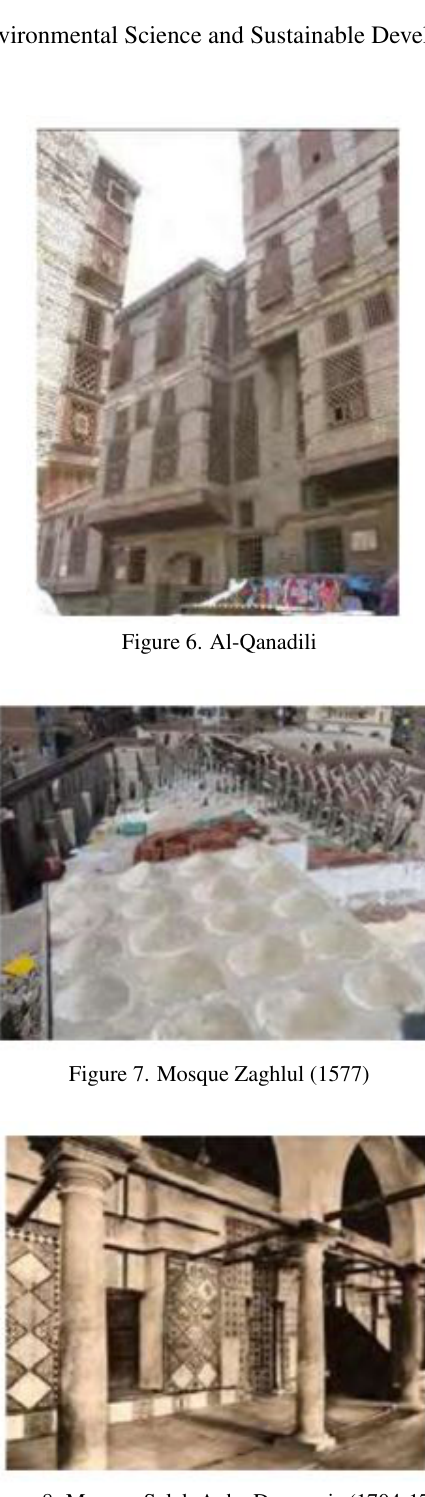
Figure 8. Mosque Saleh Agha Dumaqsis